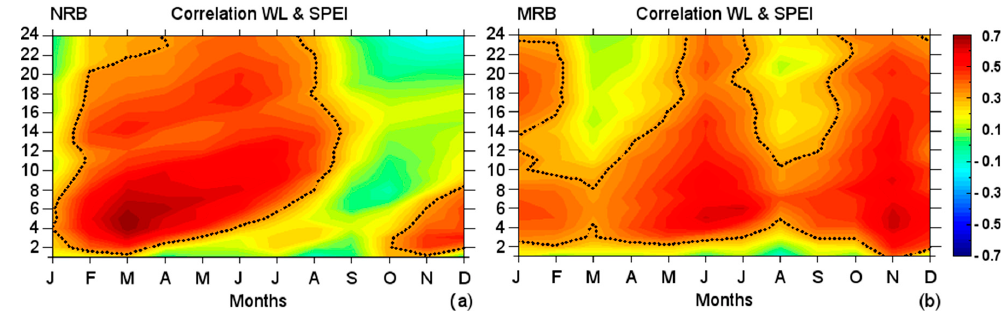
Figure 11. Monthly correlations between standardised WL anomalies and SPEI1 to SPEI24 in the NRB ( a ) and MRB ( b ). The dotted lines represent significant correlations at p < 0.05 . Period: 1980–2016.